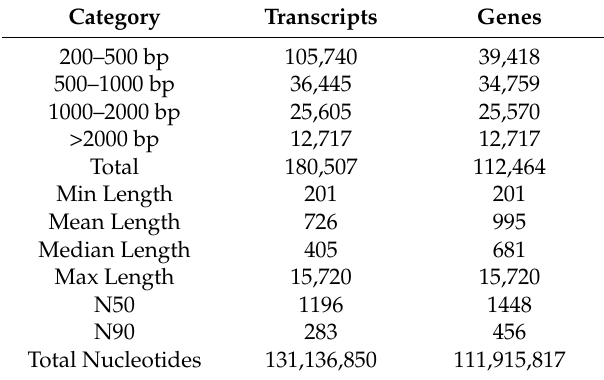
Table 2. Length distribution of the transcripts and genes clustered from the de novo assembly.